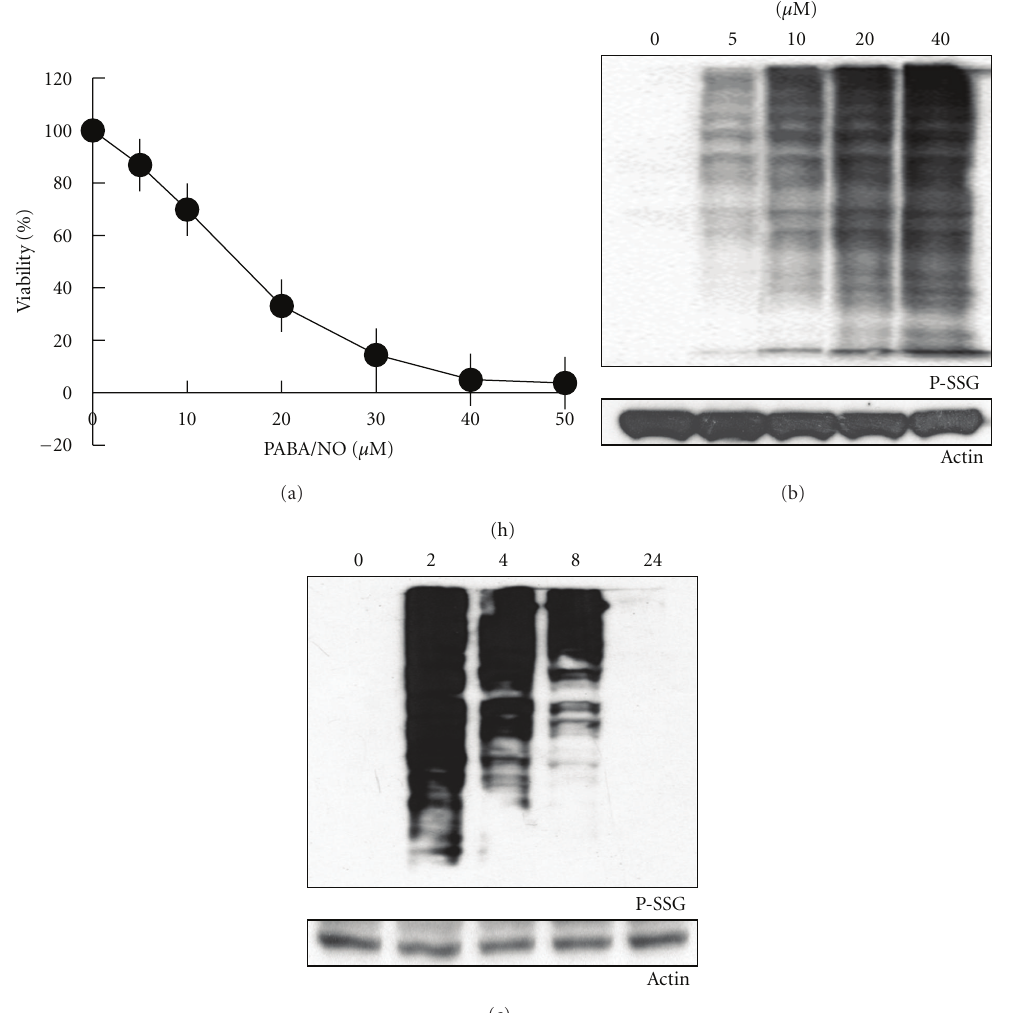
Figure 2: PABA/NO-induced S-glutathionylation of PDI in vitro . (a) MCF7 cells were seeded in a 96-well plate and treated with 0–50 μ M PABA/NO. Cell viability was measured at 72h with the MTT assay [14]. Data represent the mean for 3 independent experiments ± S.D. (b) MCF7 cells were treated with DMSO or PABA/NO at the indicated concentrations for 2h. (c) MCF7 cells were treated with DMSO or 20 μ M PABA/NO for the indicated times. Cell lysates (40 μ g) were separated and under nonreducing conditions and subjected to Western blot with anti-S-glutathionylation (P-SSG) and antiactin